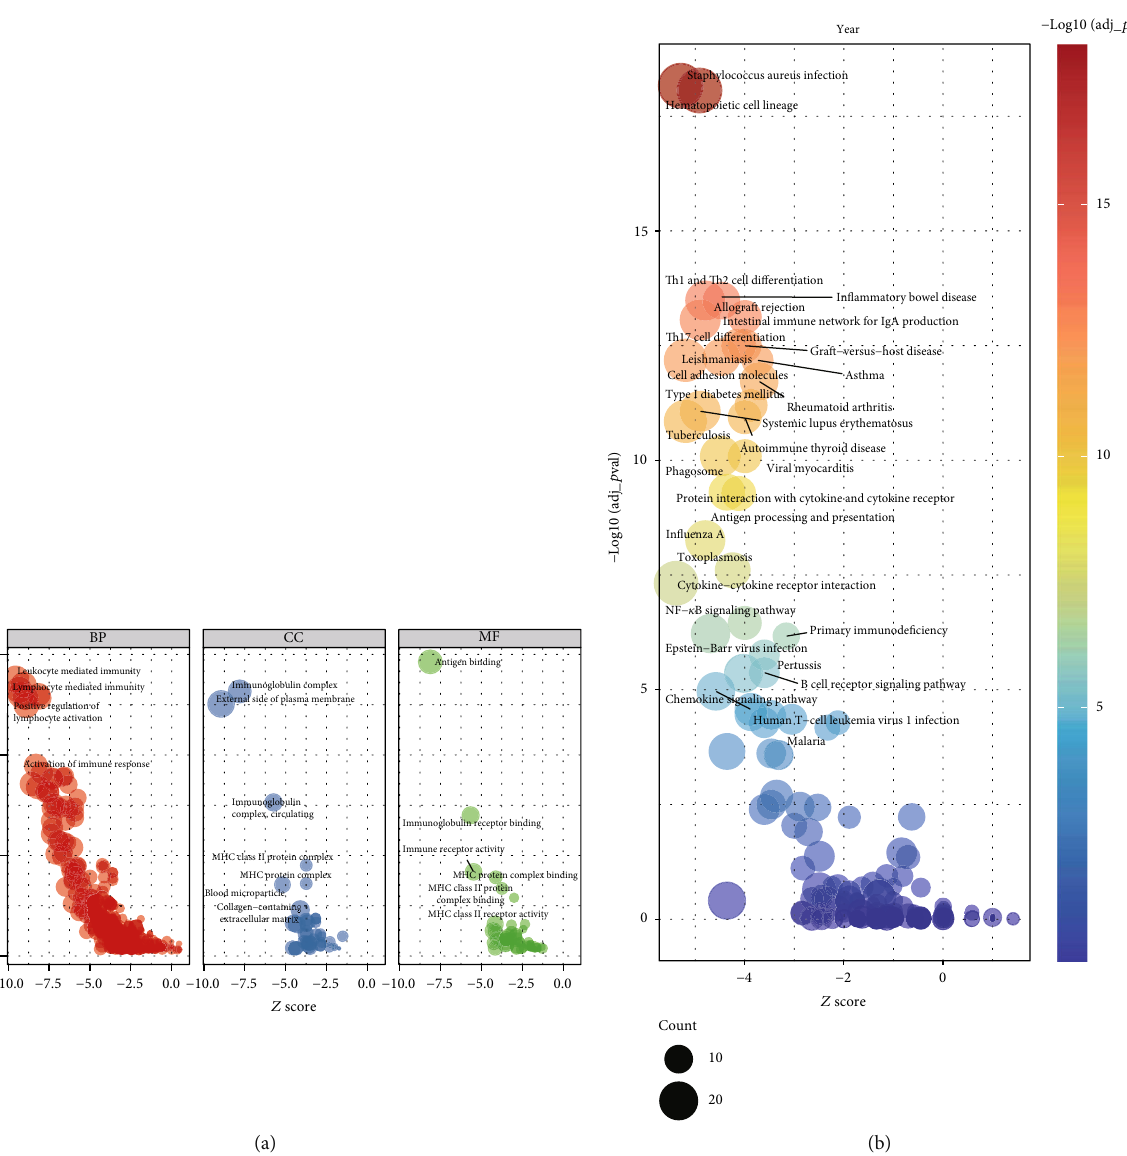
Figure 5: Pathway enrichment analysis of high- and low-risk scores in CD8-DEG model. (a) GO analysis of CD8-DEGs model. (b) KEGG analysis of CD8-DEG